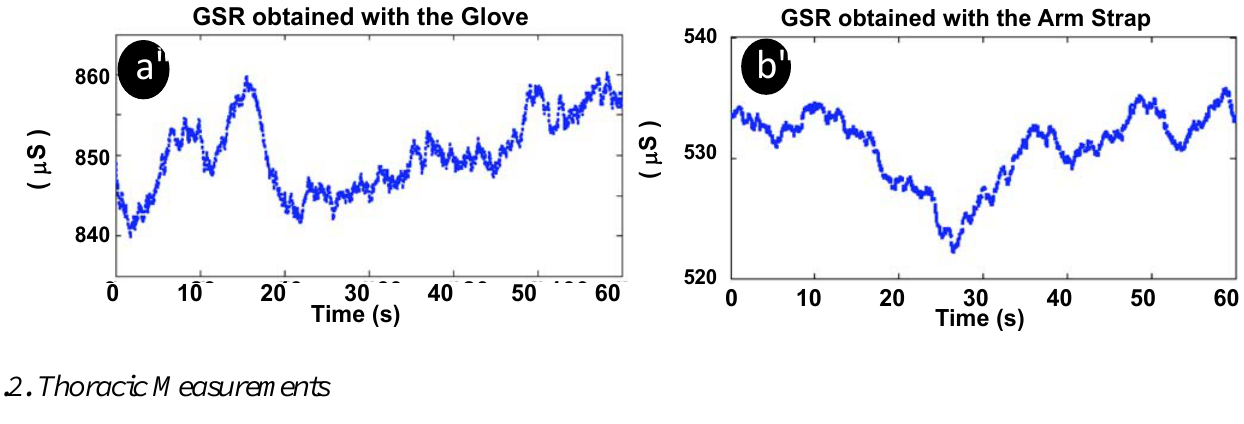
Figure 12. Galvanic skin response measurements. ( a ) Glove. ( b ) Upper arm